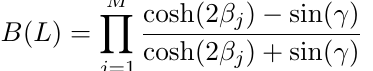
Figure 5. A graphical representation of the matrix elements ( B ) b 2 L b 2 L (cid:0) 1 :::b 1 a operator (18) for the chain of length 2 L = 6. Summation over the spin indices assigned to internal edges is assumed. Note that for (quasi) periodic boundary conditions, A and A 0 should be